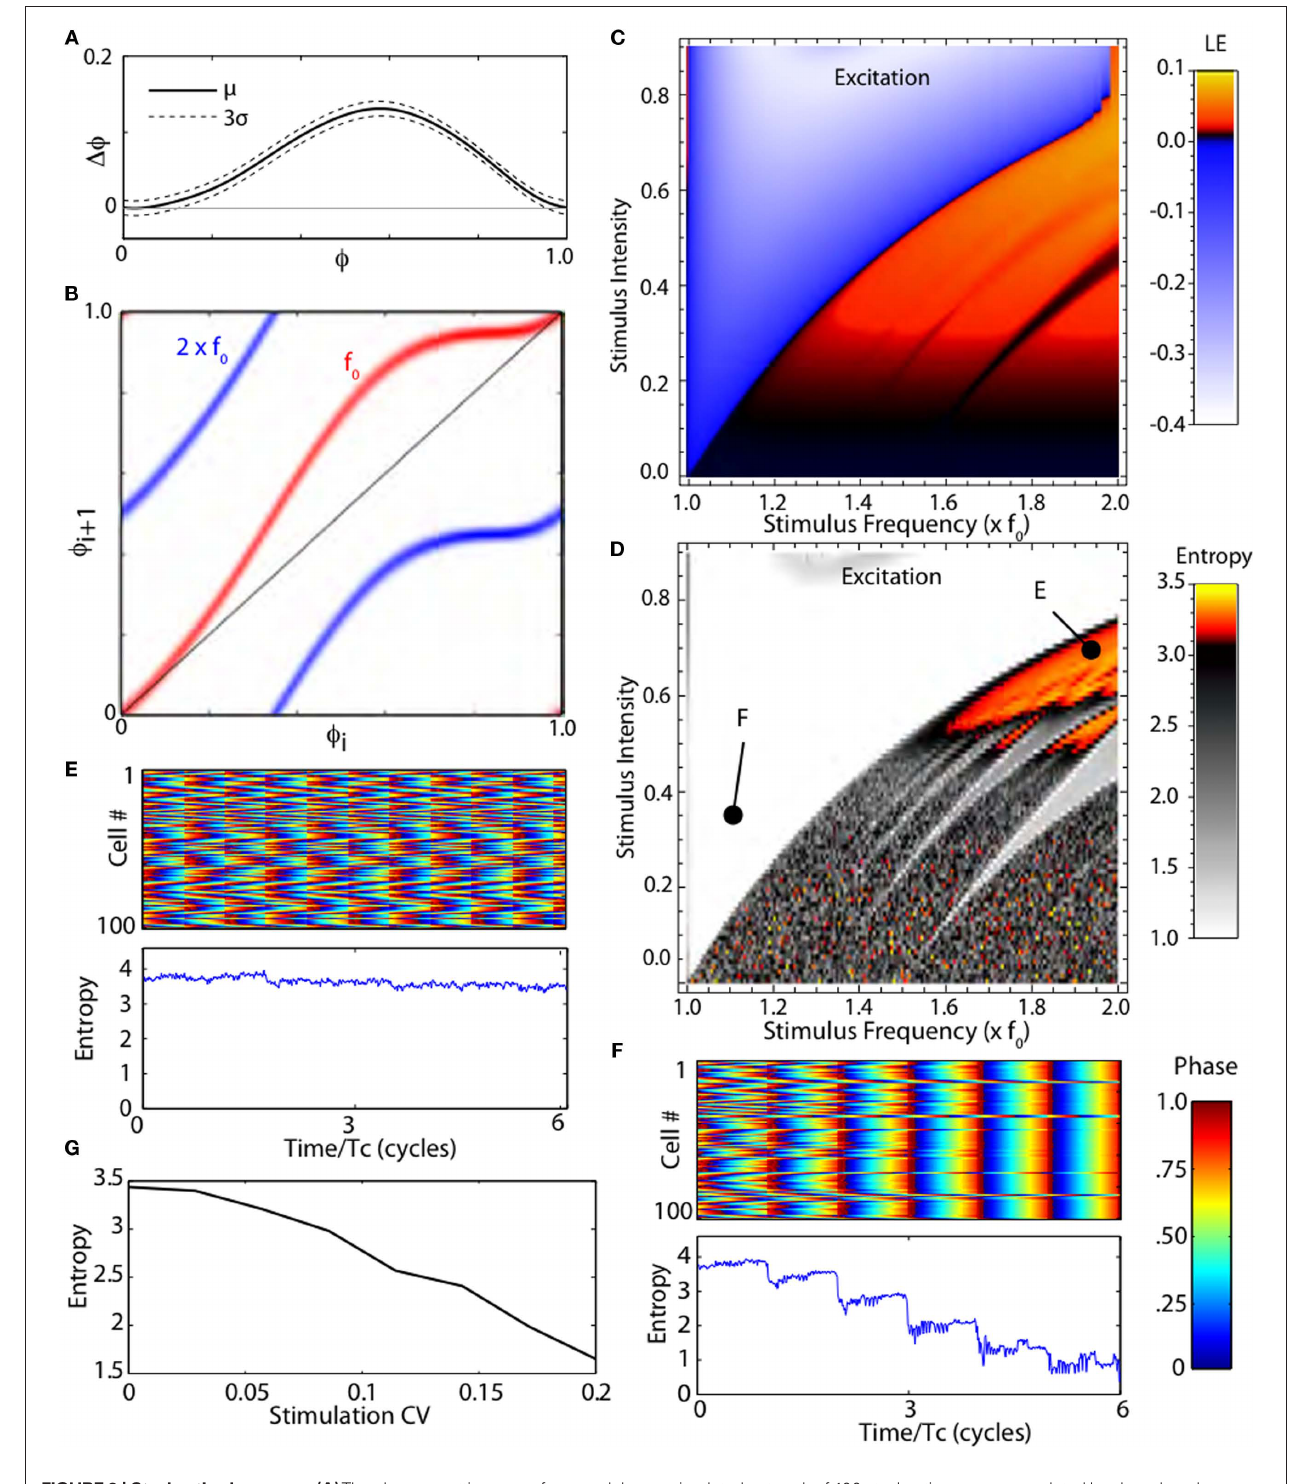
Figure 3 | Stochastic phase map. (A) The phase-resetting curve for a model neuron in globus pallidus with confidence intervals. (B) Stochastic maps for periodic stimulation at two frequencies, the cell’s natural frequency ( f twice that. The stochastic map gives the probability distribution of stimulus phases on the next interspike interval given a distribution for the previous interval. (C) Lyapunov exponents for the stochastic map. (D) Entropy of a